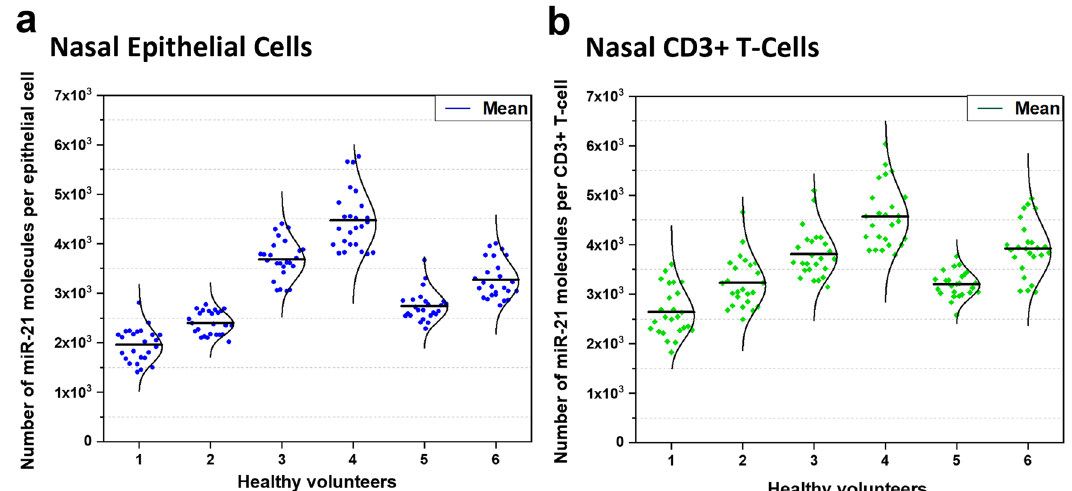
Fig. 5 Baseline expression of miR-21 in nasal epithelial cells and CD3 + T-cells collected from six healthy volunteers. Nasal cells were collected using SAM. Nasal fl uid and cells were separated using centrifugation. On the same day of collection, single-cell analysis was performed to quantify levels of miR- 21 in cells. For each volunteer, nasal cell sample was analysed on separate a micro fl uidic chip. EpCAM + epithelial cells ( ʎ = 488 nm) and CD3 + T-cells ( ʎ = 532 nm) were isolated into individual micro-chambers. Relative single molecule count detected from raw TIRF images were converted into absolute number of miRNA using the corresponding calibration curves. Distribution of miR-21 molecules expressed in a epithelial cells (Blue; 25 cells) and b CD3 + T-cells (Green; 25 cells) at a single-cell level for each volunteer (1 – 6). Normal or gamma distribution curves were used to fi t the data to highlight the shape of each distribution with the solid black line representing the mean.